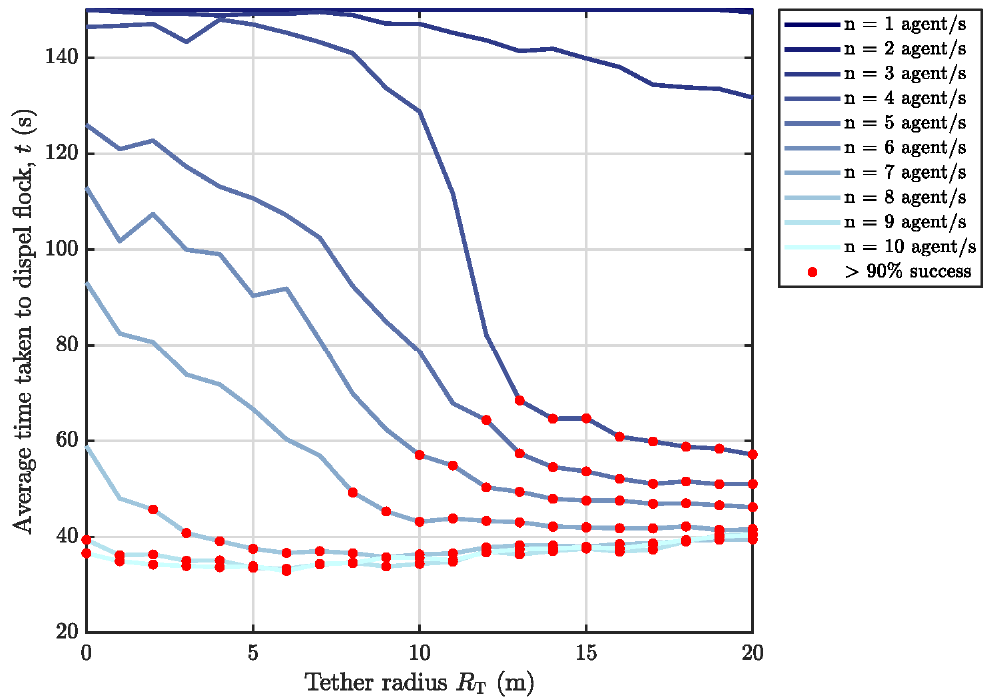
Figure 8. Single target flock scenarios–time performance (darker lines indicate fewer agent numbers while red markers indicate data points whose average success rate is above the given threshold across the 300 independent simulation runs). Maximum agent speed: 𝑣 max = 12 m/s.